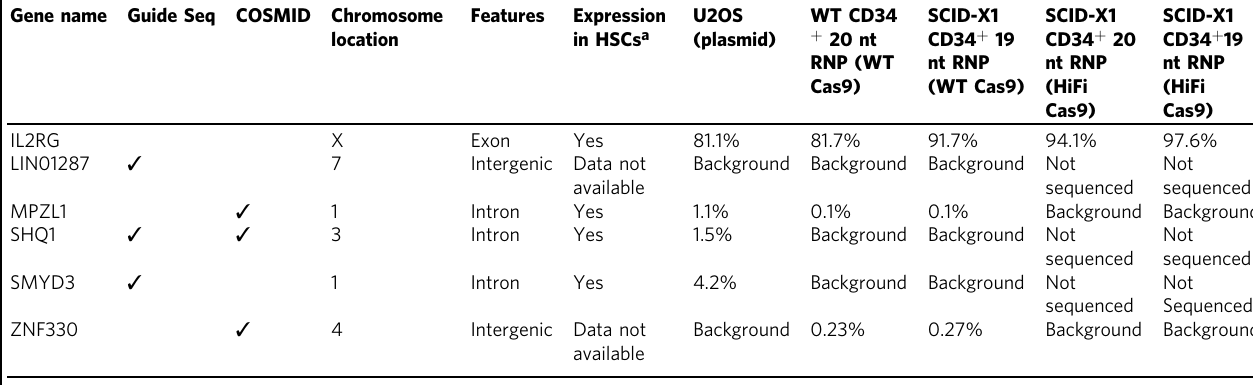
Table 4 Summary of IL2RG sgRNA off-target INDEL frequency analysis Gene name Guide Seq COSMID Chromosome